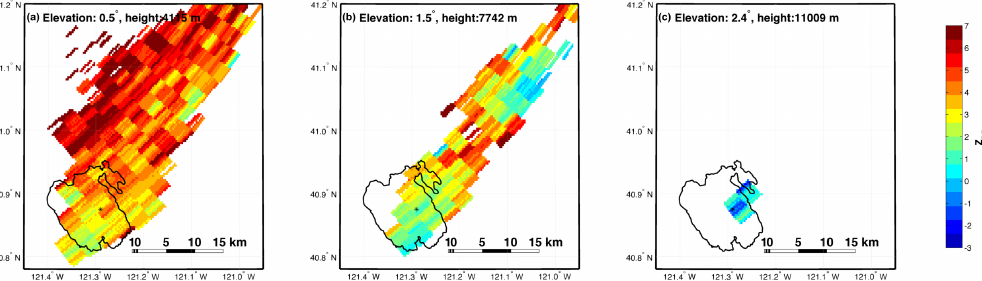
Figure 8. Differential reflectivity ( Z dr ) analysis of the Bald Fire plume at 14:29PDT. (a–c) Z dr at the 0.5, 1.5, and 2.4 ◦ elevation sweeps. The black contour shows the fire perimeter on 2